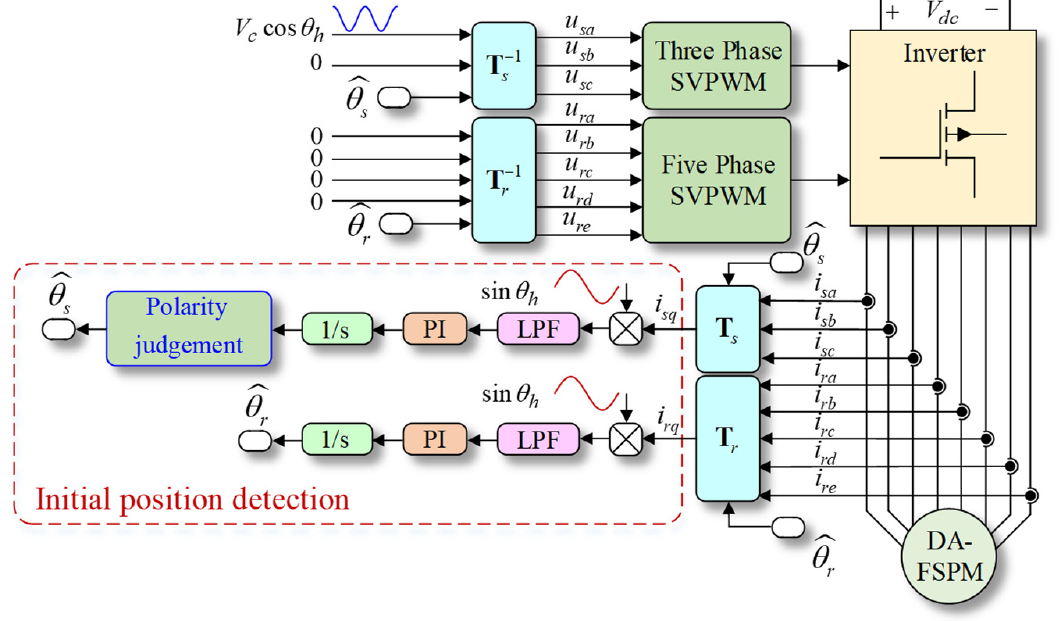
Figure 7. The initial position detection scheme based on the stator side high-frequency voltage in- jection.